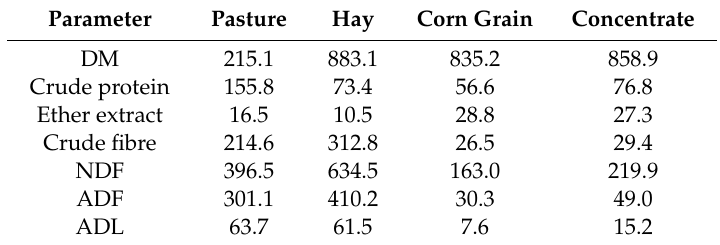
Table 1. Dry matter (DM, g kg − 1 ) and chemical composition (g kg − 1 of DM) of the di ff erent feeds.